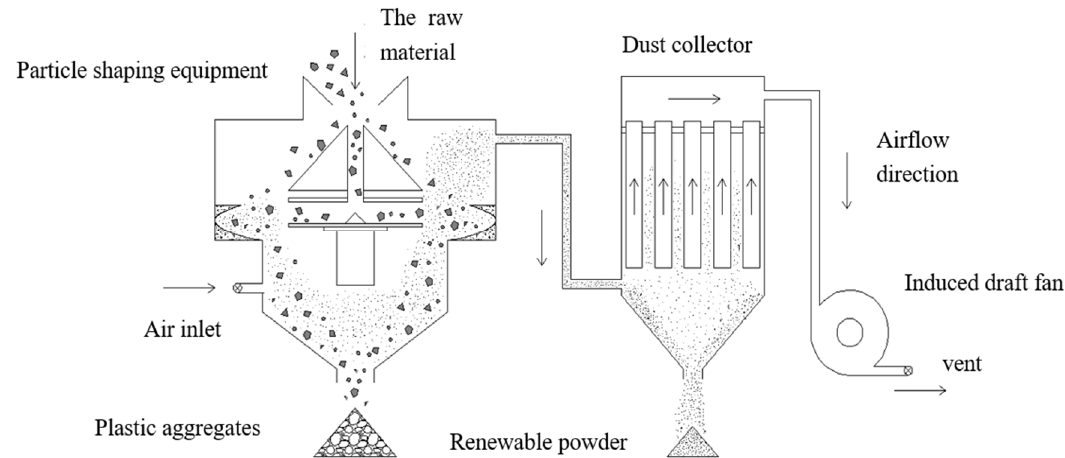
Figure 1. Schematic diagram of the particle shaping equipment.